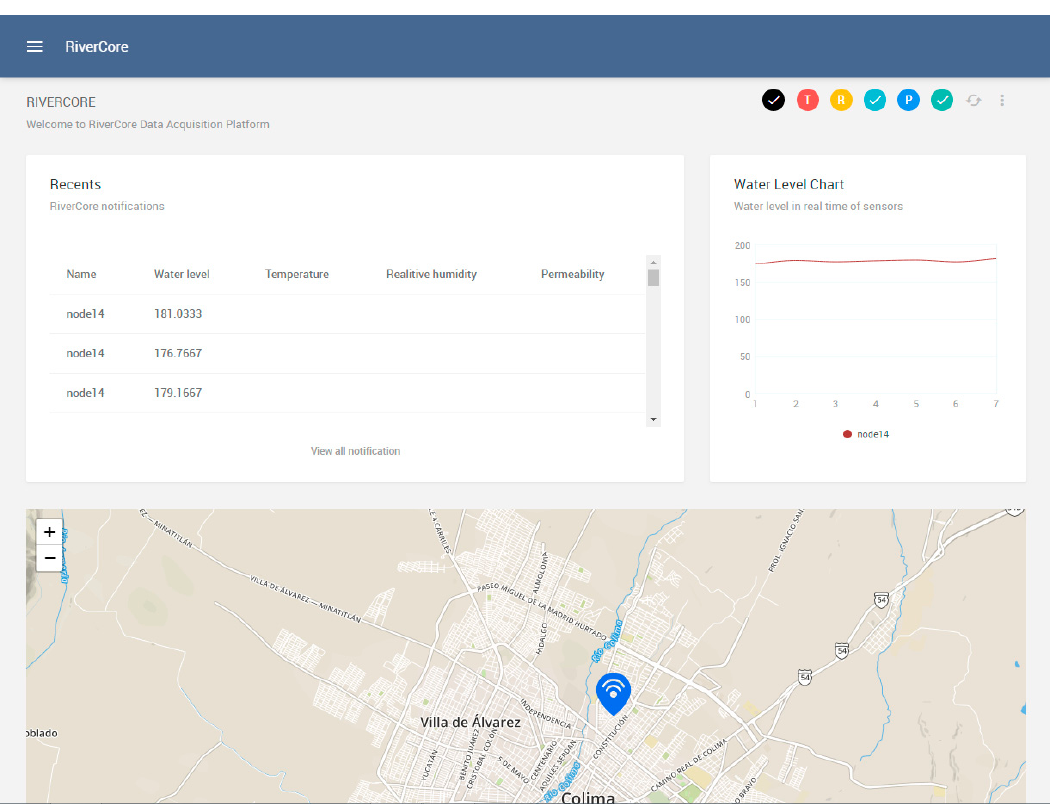
Figure 9. Cloud platform main view.